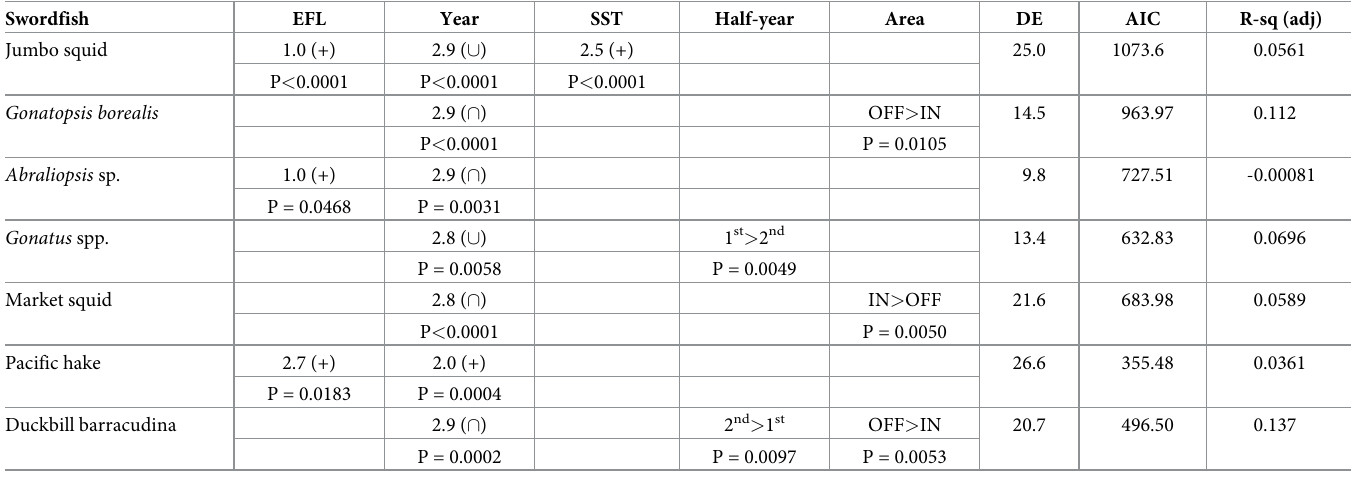
Table 5. Effect of explanatory variables on the presence of the main prey taxa in swordfish diet (form and direction of the relationship and statistical significance). The first row for each species-variable combination contains the estimated degrees of freedom (edf) in the case of smoothers. The second row indicates the probability. Only significant effects, retained in the final models, are shown. Swordfish body length was measured as eye-to-fork length (EFL, cm). DE = deviance explained, AIC = value of the Akaike Information Criterion, R-sq (adj) = value of adjusted R-squared. Blank cells indicate non-significant effects that were dropped during model selection. 1 st = first half of year, 2 nd = second half of year; IN = within the SCB, OFF = beyond the SCB